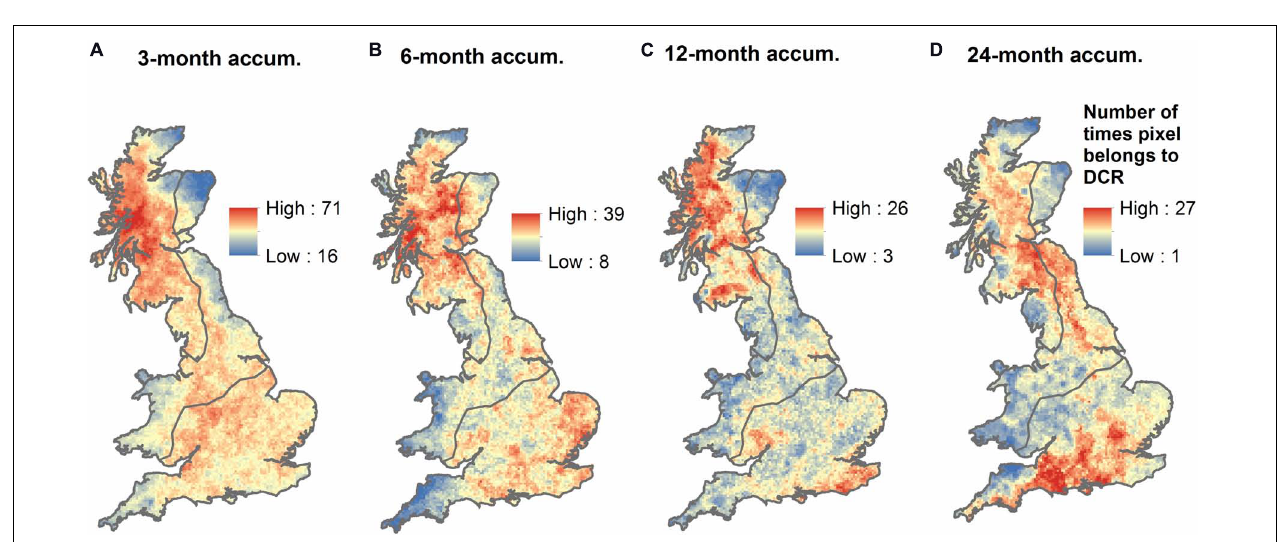
FIGURE 9 | Number of times each pixel belonged to the DCR of a drought event in all drought events detected between 1862 and 2015 (based on severity) for accumulation periods of (A) 3 months, (B) 6 months, (C) 12 months, and (D) 24